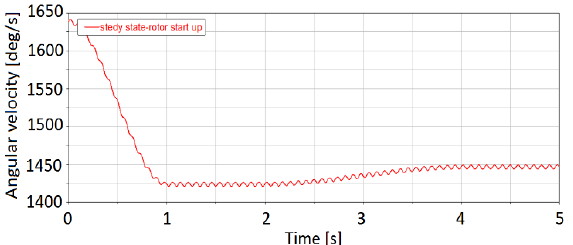
Fig. 16. Harmonics of the power required for hovering – I h power pulsa- tion